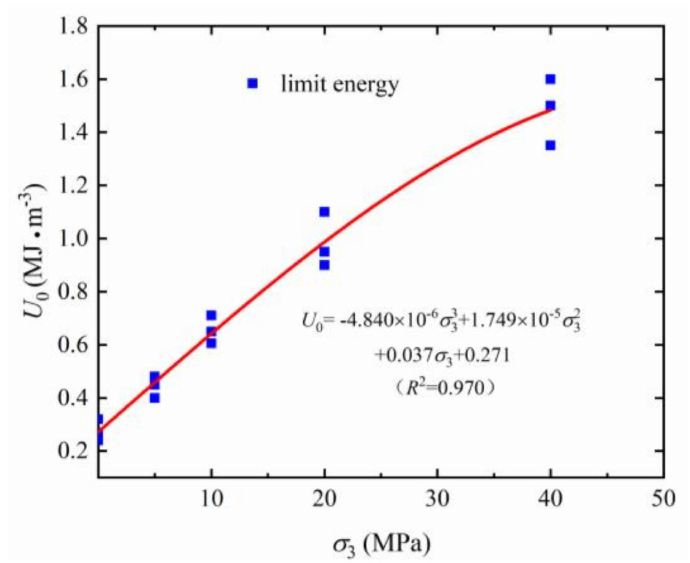
Figure 10. Limiting energy value of granite.